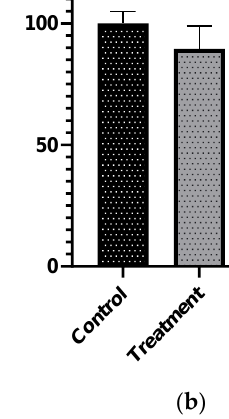
Figure 4. ( a ) There was no significant decrease in the cell viability of MG63 cells when the cells were exposed to di ff erent drug release samples from di ff erent time points, day = 1, 7, and 21 ( α = 0.05, n = 4), compared to the control cell receiving only phosphate bu ff ered saline. ( b ) When the drug was released from ABVF placed inside transwell inserts, the treatment cells did not show any significant di ff erence compared to the control cell ( α = 0.05, n =